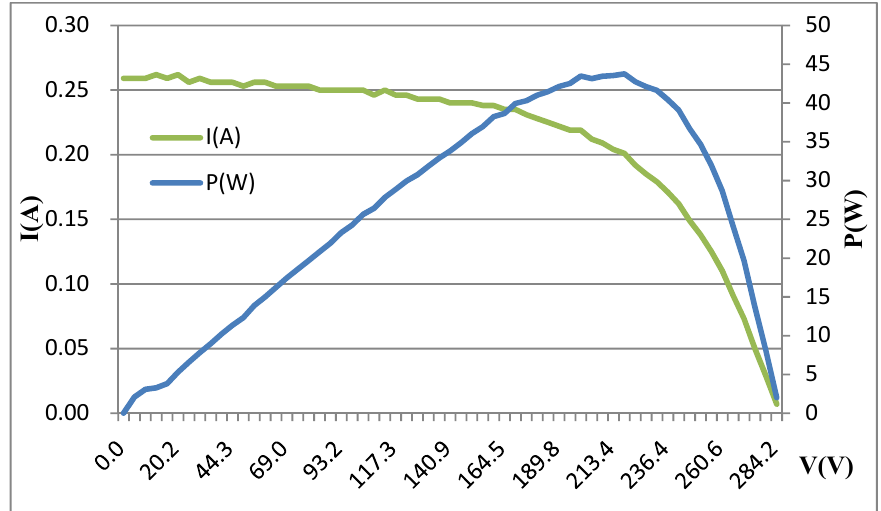
Figure 7. The I – V curve of STPV window at noon on 13 February.